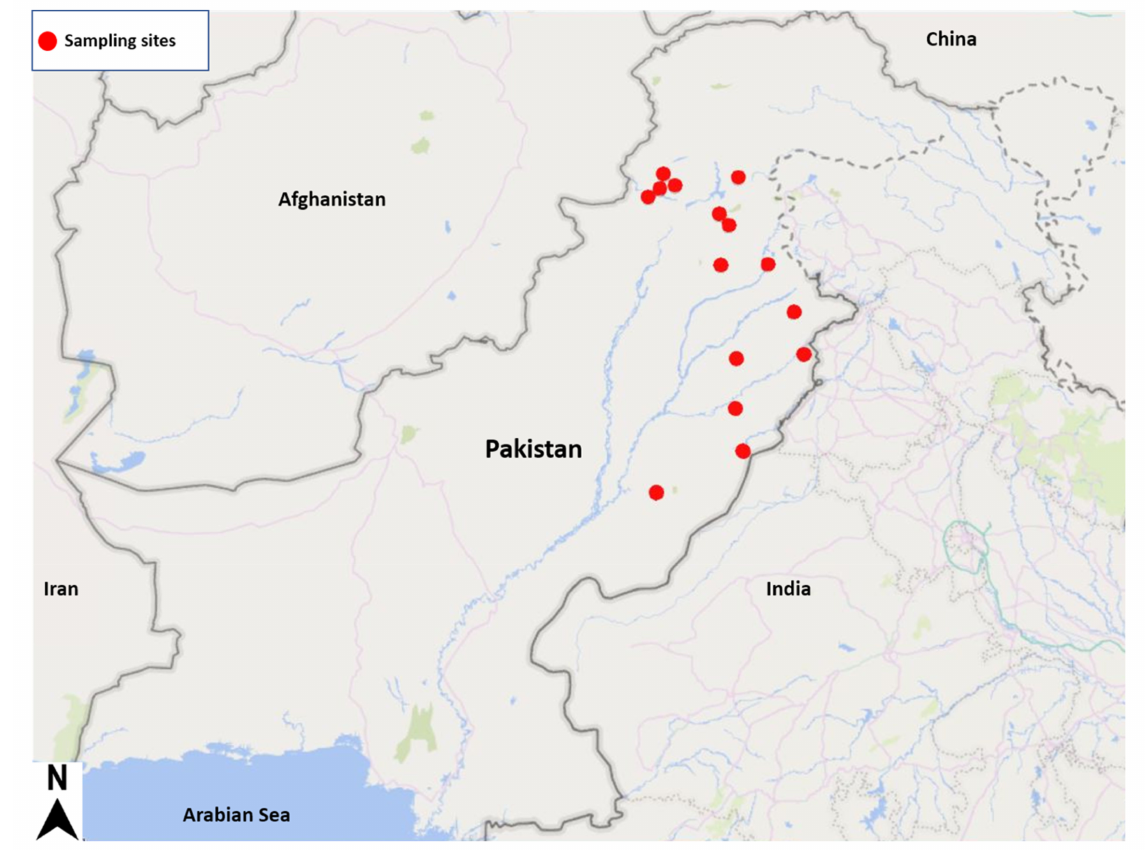
Figure 1. Geographic map of Pakistan showing sampling sites for Karnal bunt (KB)